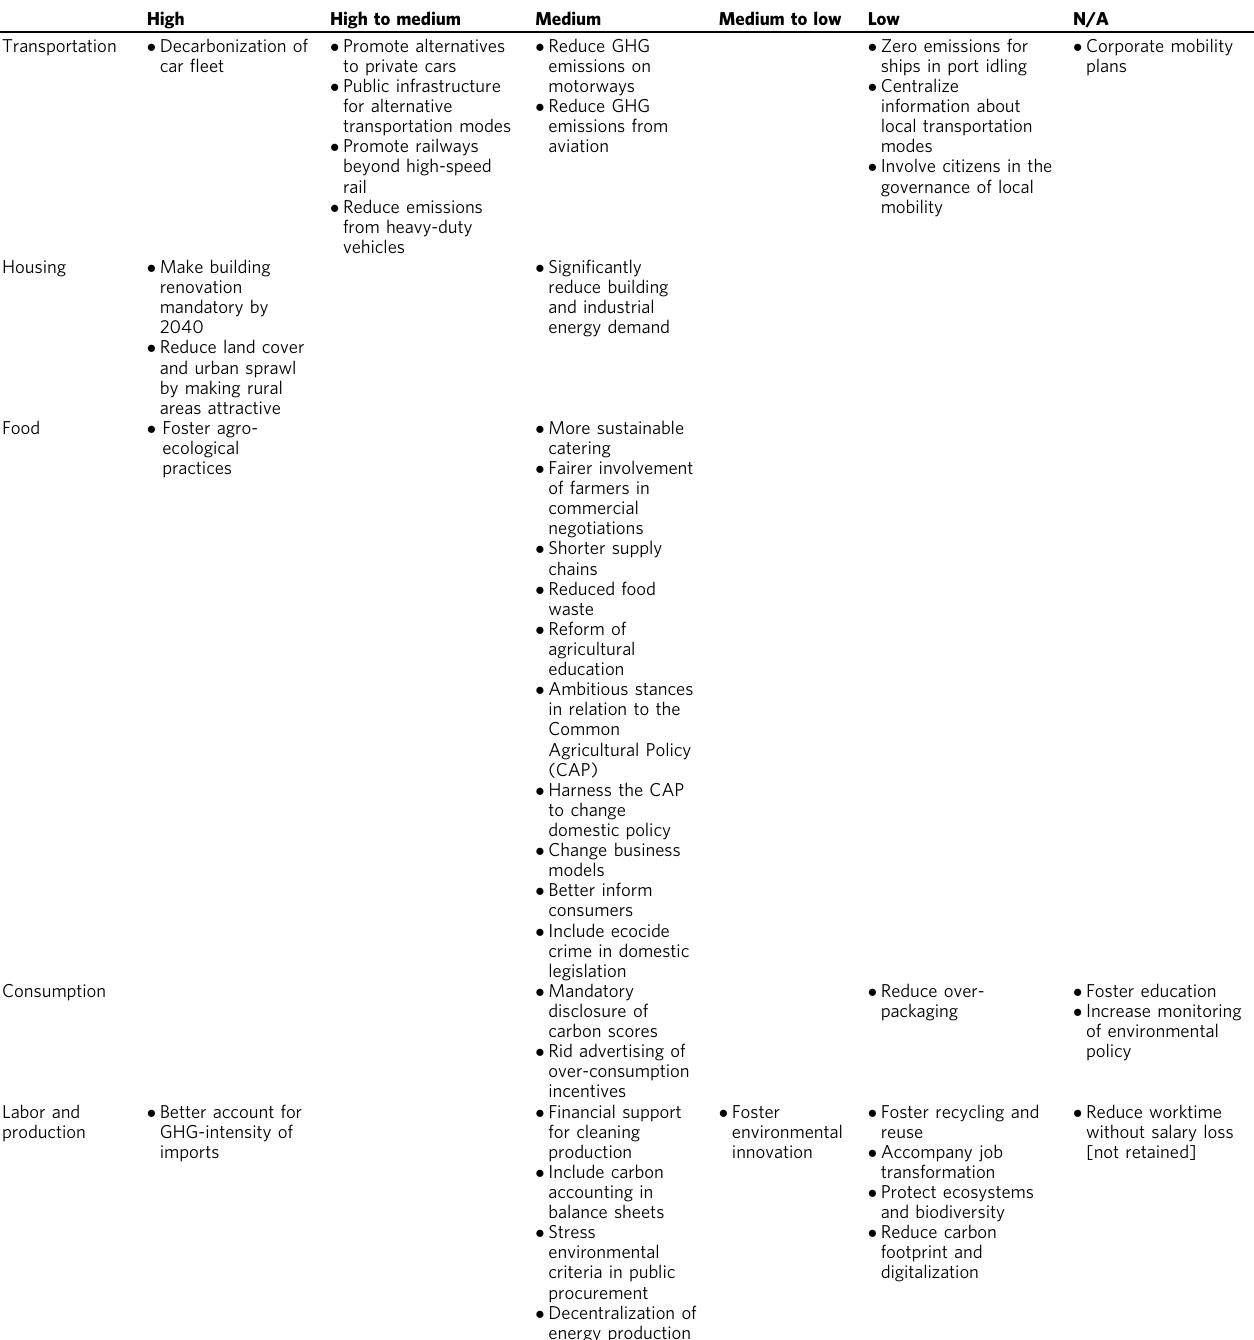
Table 3 Strength of the impact of the blocks of measures proposed in each sector, as assessed by the technical advisory group.